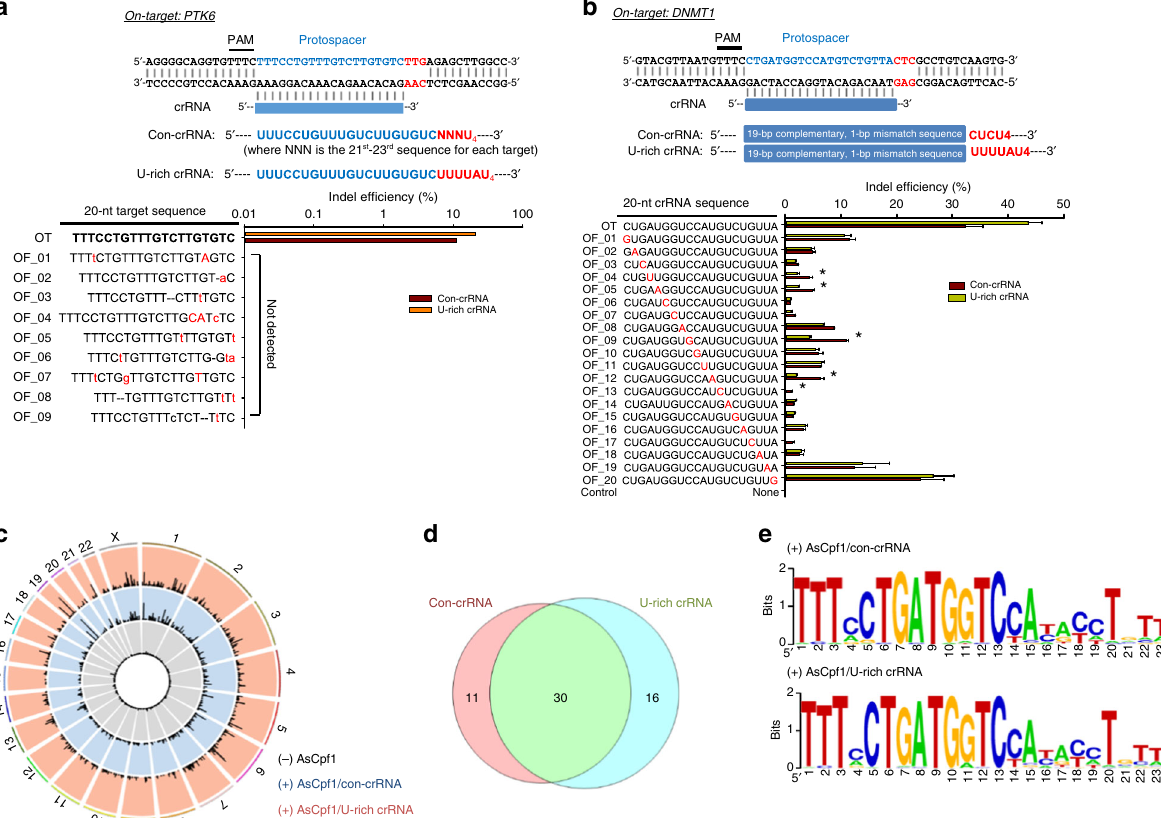
Fig. 4 No in fl uence of the U-rich crRNA on off-target effects. a Comparison of the off-target activity of conventional and U-rich crRNA-guided AsCpf1 at potential off-target sites. Off-target activity was measured by deep sequencing at potential off-target sites with <2 bulges and 2 mismatches against an on- target sequence of phospho-tyrosine kinase 6 ( PTK6 ). The use of U-rich crRNA did not harm the speci fi city of AsCpf1, whereas it contributed to the increased on-target activity of Cpf1. b Comparison of the off-target activity of AsCpf1 between the conventional and U-rich crRNA with a one-base mismatch against an on-target sequence. The indel ef fi ciency was calculated from the T7E1 indel assays. The use of a U-rich crRNA effectively lowered the tolerance of a single base mismatch at several positions, thereby contributing to the enhanced AsCpf1 speci fi city. * p < 0.05, compared with U-rich crRNA, two-tailed Student ’ s t test. c The genome-wide Circos plot for the off-target sites identi fi ed by Digenome-seq analysis with a DNMT1 on-target site. d The number of off-target sites for canonical and U-rich crRNA. e The sequence logo analysis for recognition of the target sequence. The recognition pattern was equally conserved for the both crRNAs